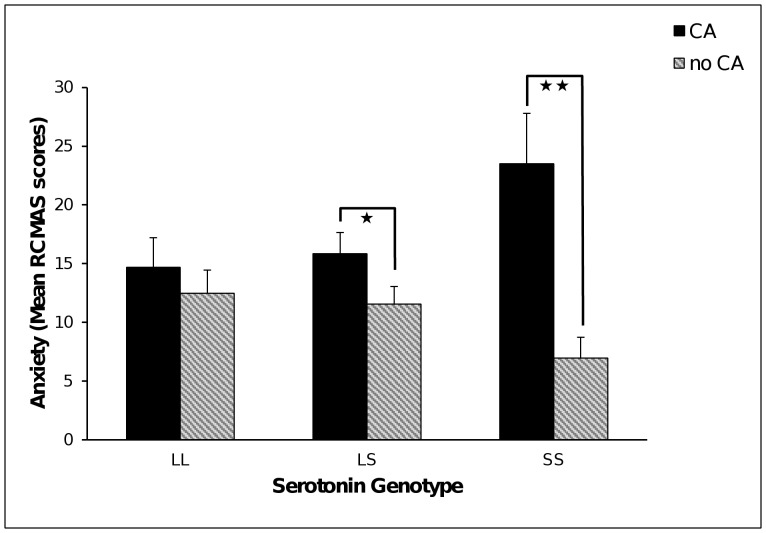
Mean scores of self-reported anxiety symptoms by gene variants in 5-HTTLPR and early childhood adversities (CA).Error bars represent ±1 SE of the mean. * p<0.05; ** p<0.001.